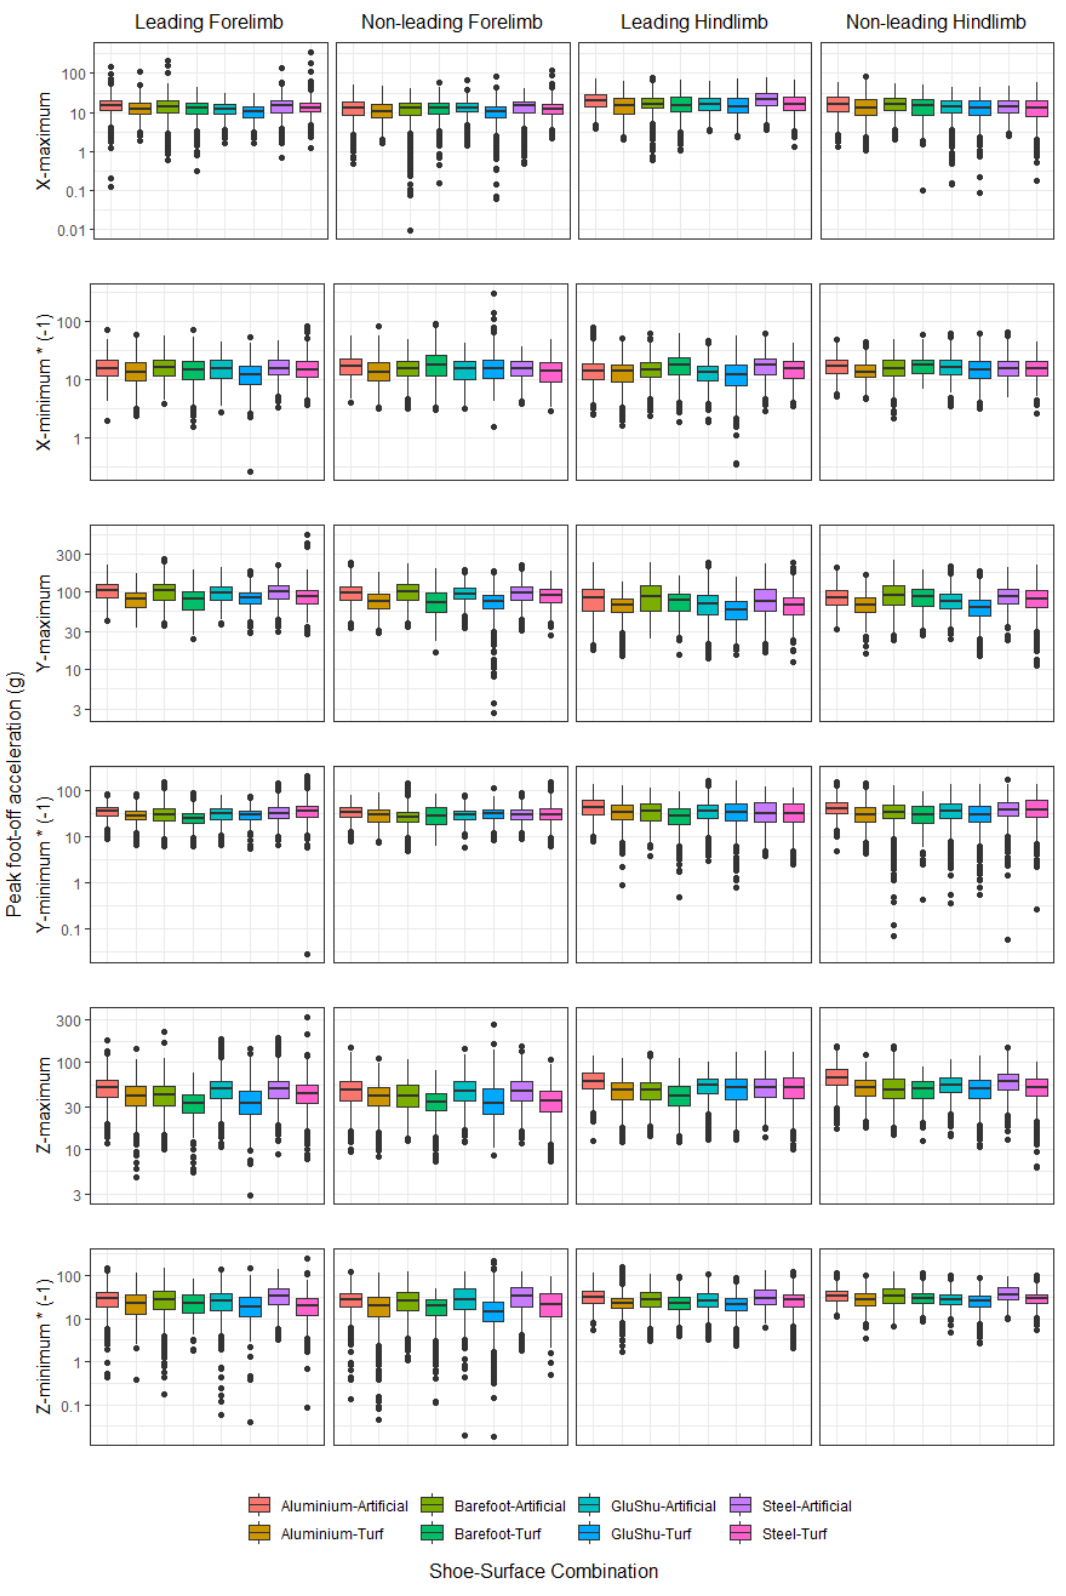
Figure A2. Boxplots illustrating minimum and maximum foot-off accelerations per shoe–surface combination. The p -values for pairwise comparisons (with Bonferroni correction) are provided in Supplementary Table S7. Please note that ‘*’ indicates ‘multiplied